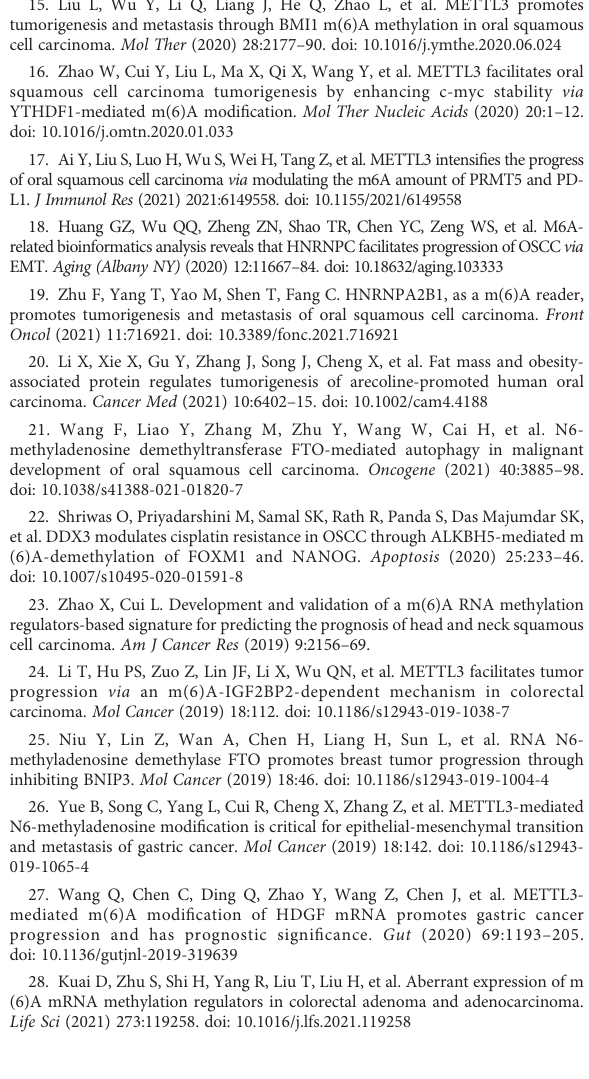
SUPPLEMENTARY FIGURE 1 Hierarchical clustering heatmap of the top 100 differentially expressed genes in DOK and SCC-9 cells compared with HOEC cells. (A) HOEC VS DOK; (B) HOEC VS